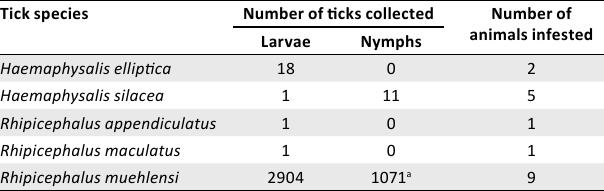
TABLE 1: Species and number of ticks collected from nine four-toed elephant shrews in north-eastern KwaZulu-Natal. Tick species Number of ticks collected Number of